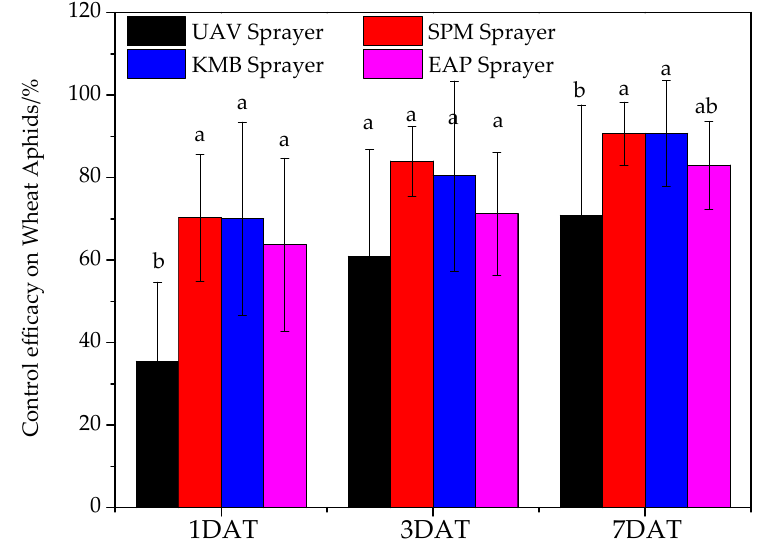
Figure 6. Control efficacy (%) of four sprayers against wheat aphids in the field tests at Days 1, 3, 7 after treatment. DAT, days after treatment.